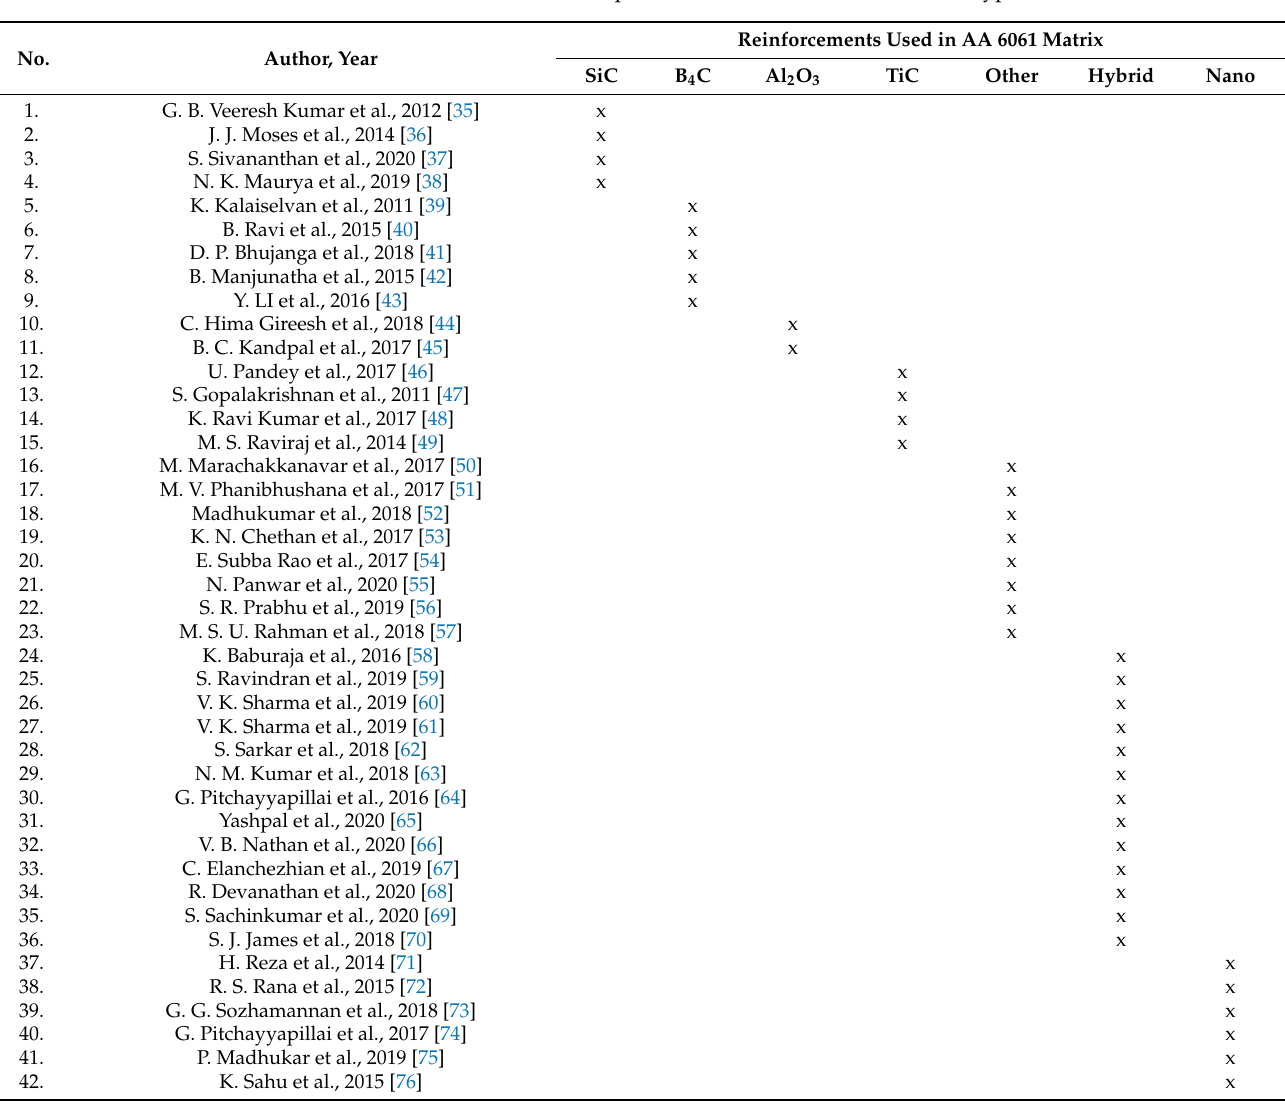
Table 2. List of studies of AA 6061 composites with different reinforcement